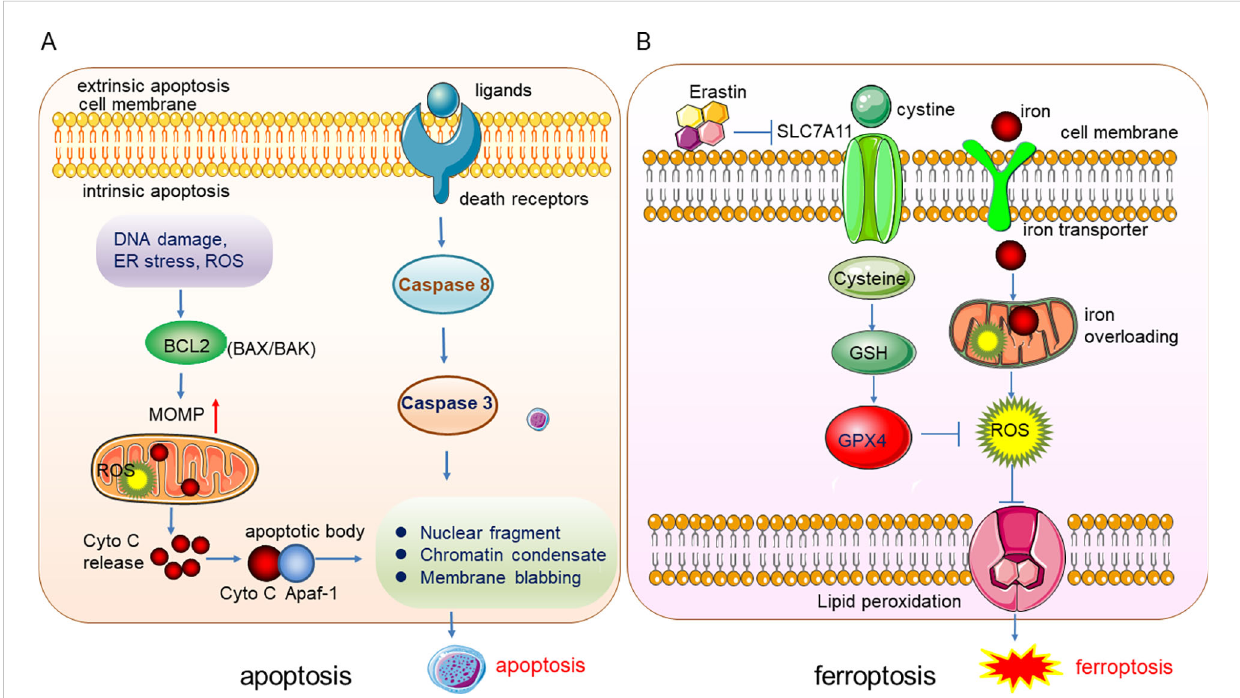
FIGURE 1 Illustration of the underlying mechanisms of apoptosis and ferroptosis. (A) The phenotype of apoptosis is characterized by the nuclear fragment, chromatin condenses and cell membrane blabbing. (B) Ferroptosis is mainly regulated by iron homeostasis and oxidative